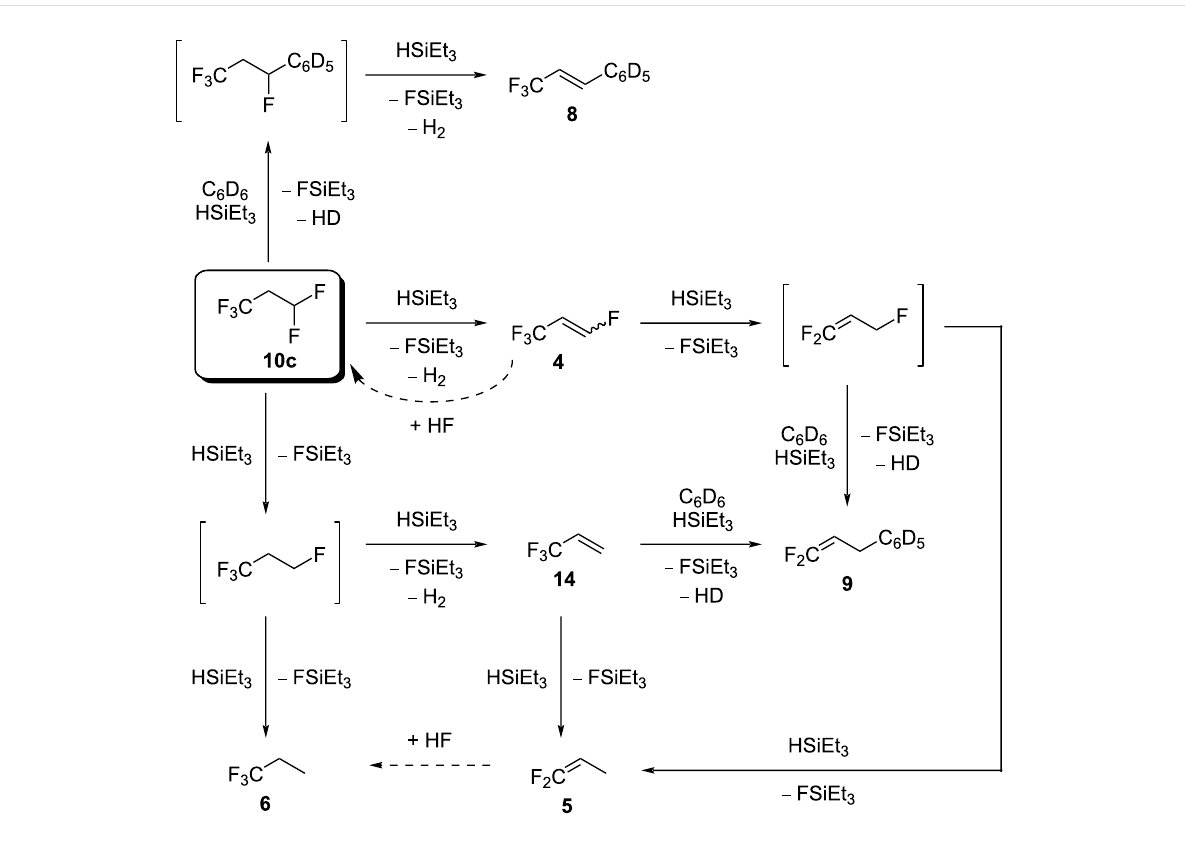
Scheme 12: Proposed reaction pathways starting from 10c in the presence of ACF and